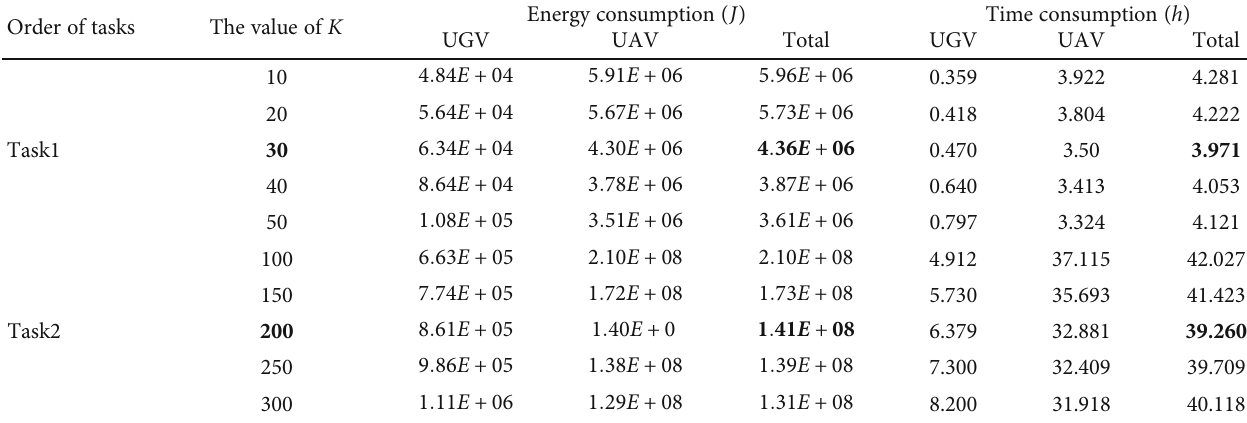
Table 6: The comparison results of the cooperative tasks with di ff erent K